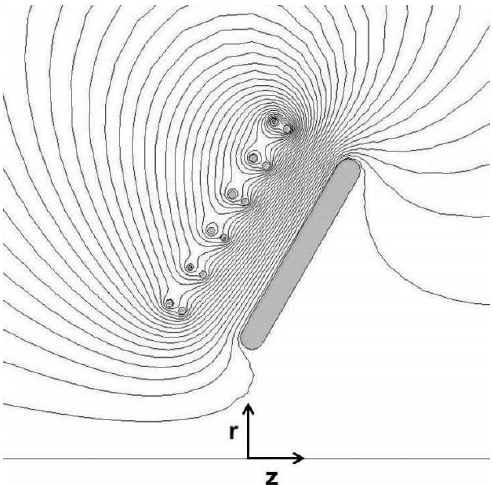
Figure 15. Magnetic flux contours calculated with QuickField for a coil with six two-turn leads in parallel and a cone angle of 60 ◦ . The plasma thickness is 1 cm. The overall dimensions of the coil are similar to the FARAD coil of Ref.